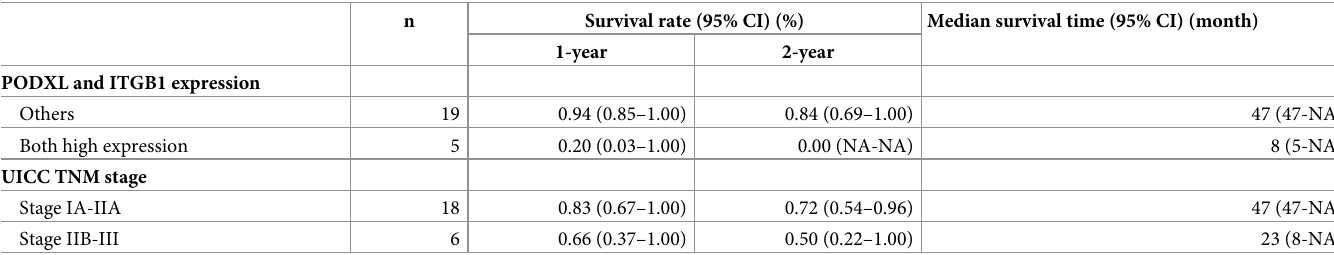
Table 3. Survival rates and median survival times of the combination of PODXL with